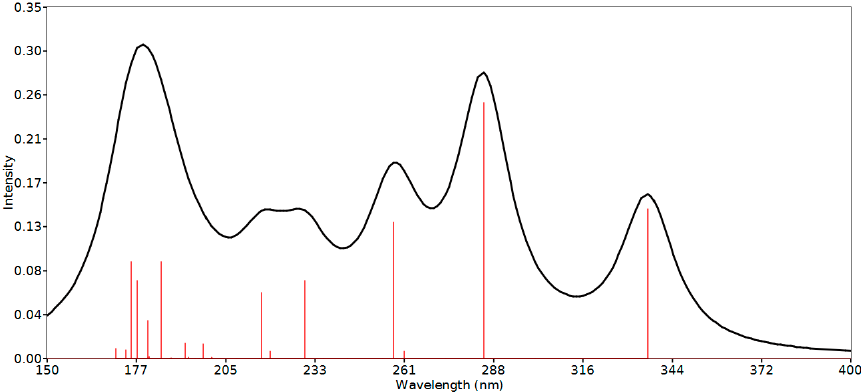
Figure 6. The calculated electronic spectrum of compound 4 using TD-DFT method.